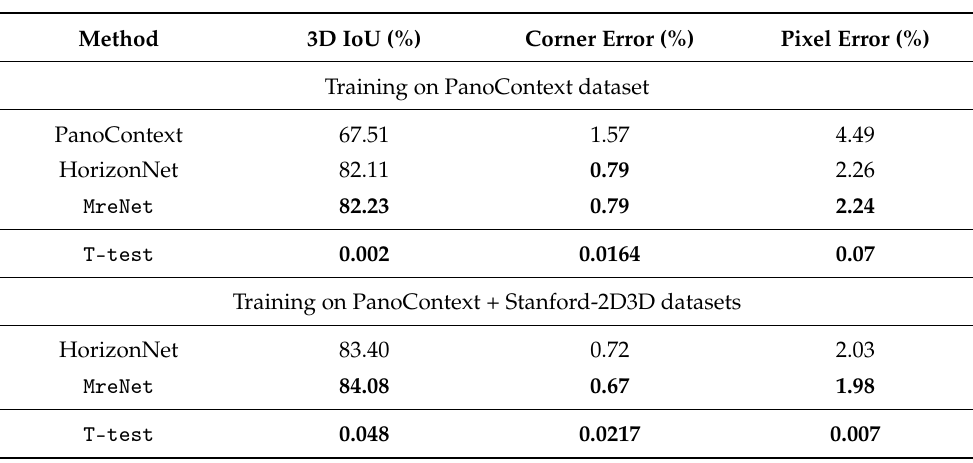
Table 1. Quantitative results of cuboid layout estimation evaluated on the PanoContext [24] dataset. Our approach outperforms all listed methods under all settings.